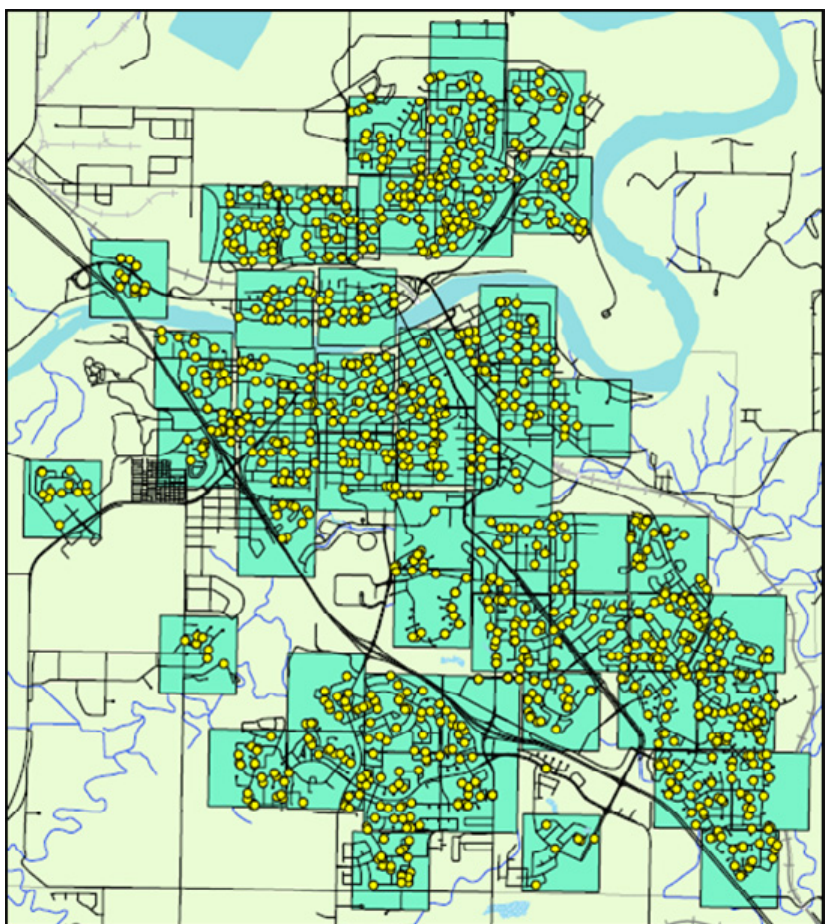
Figure 3. Distribution of phone survey participants and study areas across Medicine Hat,